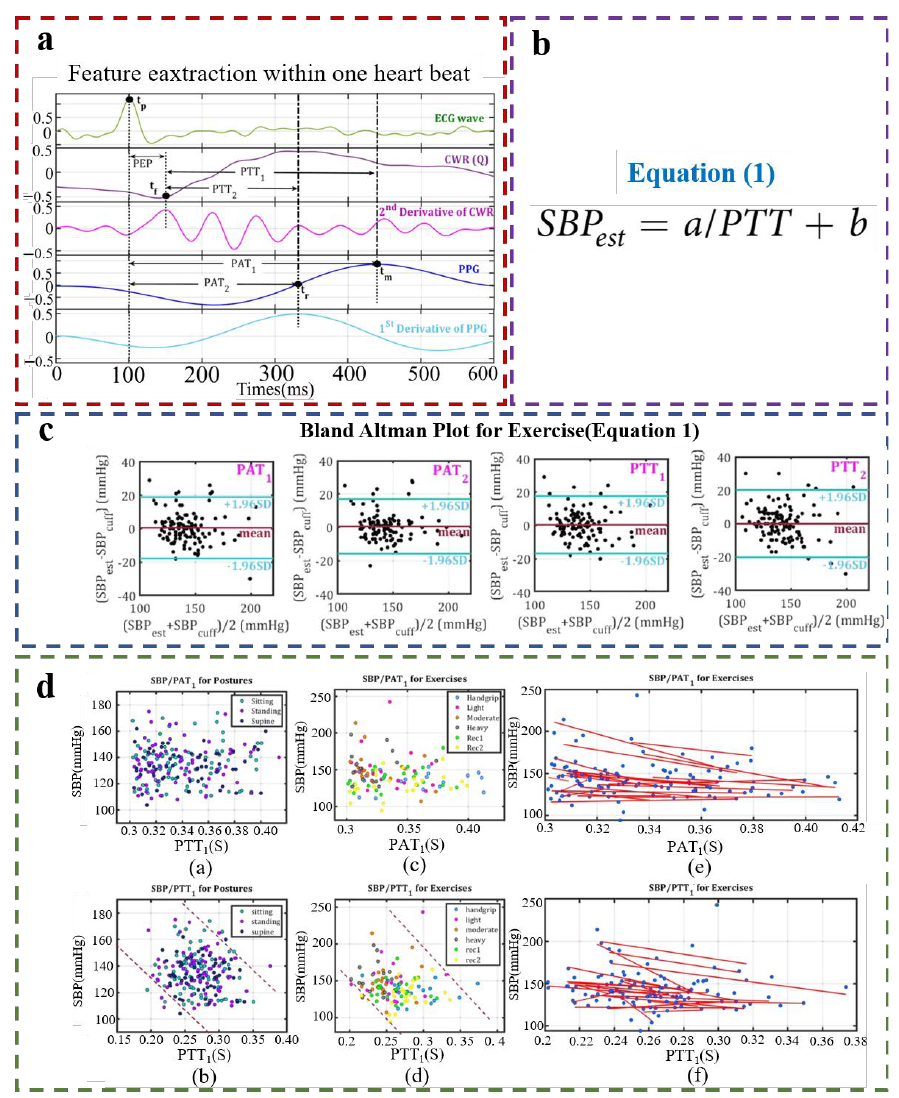
Figure 16. ( a ) Samples of ECG, CWR, PPG, the second derivative of CWRs, and the first derivative of PPGs for a subject in a standing position; ( b ) BP estimation equation; ( c ) Bland–Altman plots for exercise tasks using Equation (1); ( d ) Fitted curves of PTT and PAT to BP. Reproduced with the permission of [81].